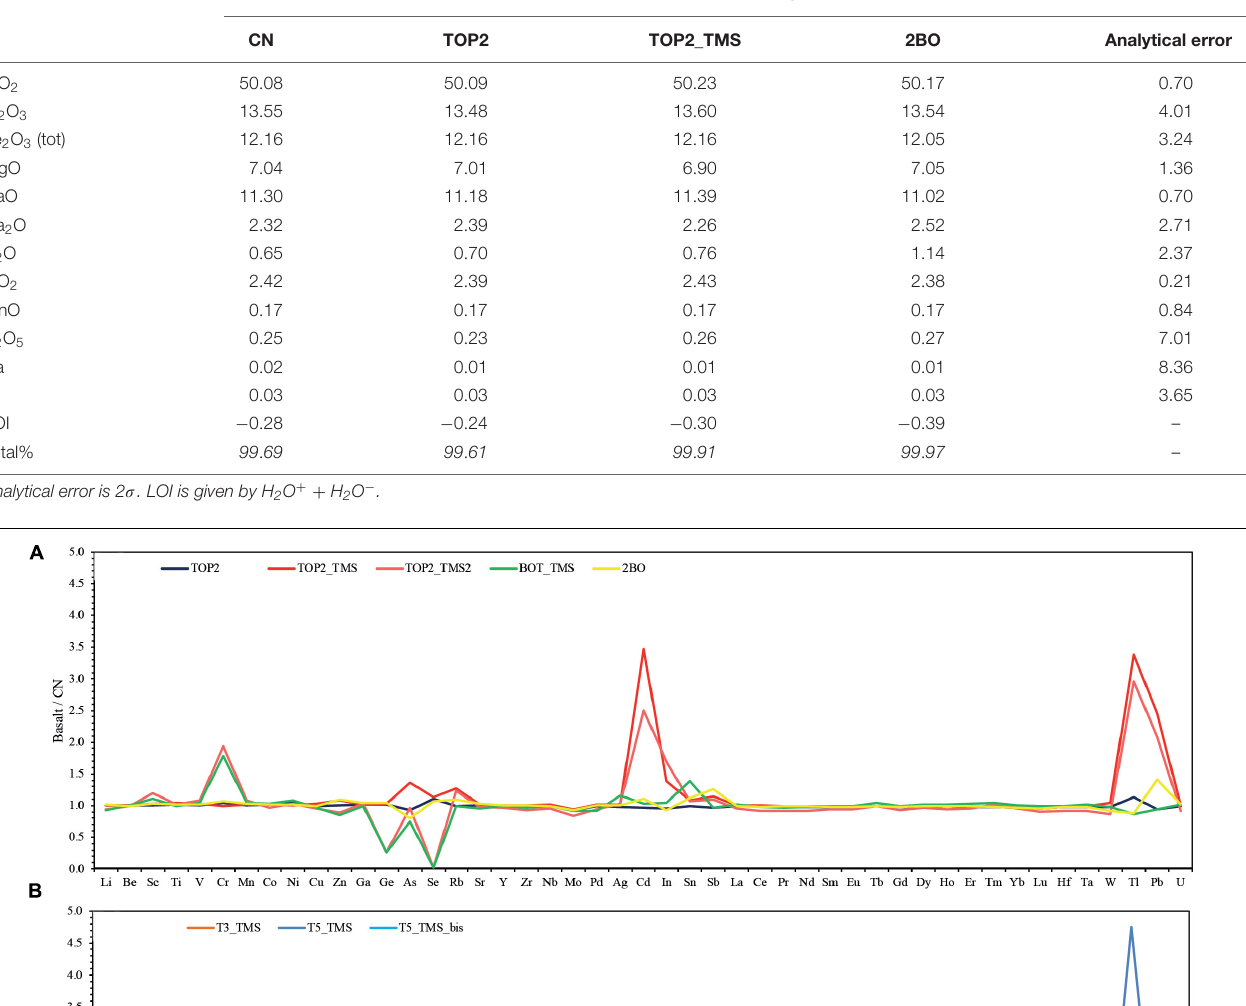
TABLE 2 | Bulk composition (ICP-AES) of the collected samples from the 27th June P¯ahoa lava flow, near the tree-mold (TOP1, TOP2, MID-A, BOT). Oxide wt.%